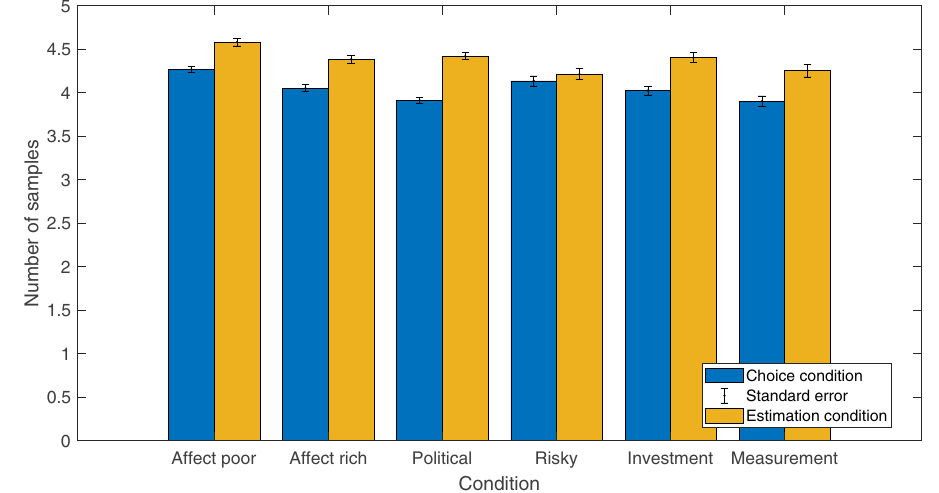
Figure 6. Mean number of samples drawn (error bars indicate standard error) for each question type in the choice (blue) and estimation (yellow) condition.